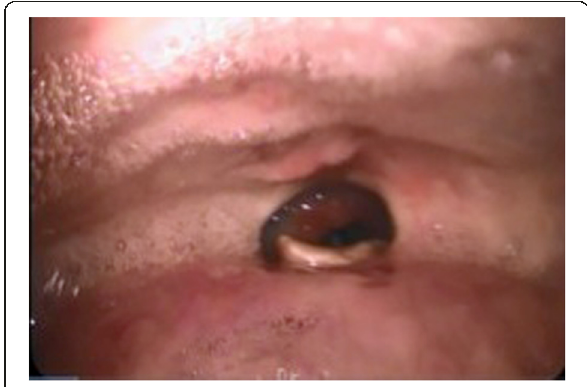
Fig. 2 Laryngofiberscopic view of the cicatrix. The diameter was about 6 mm. Epiglottis is observed beyond the opening